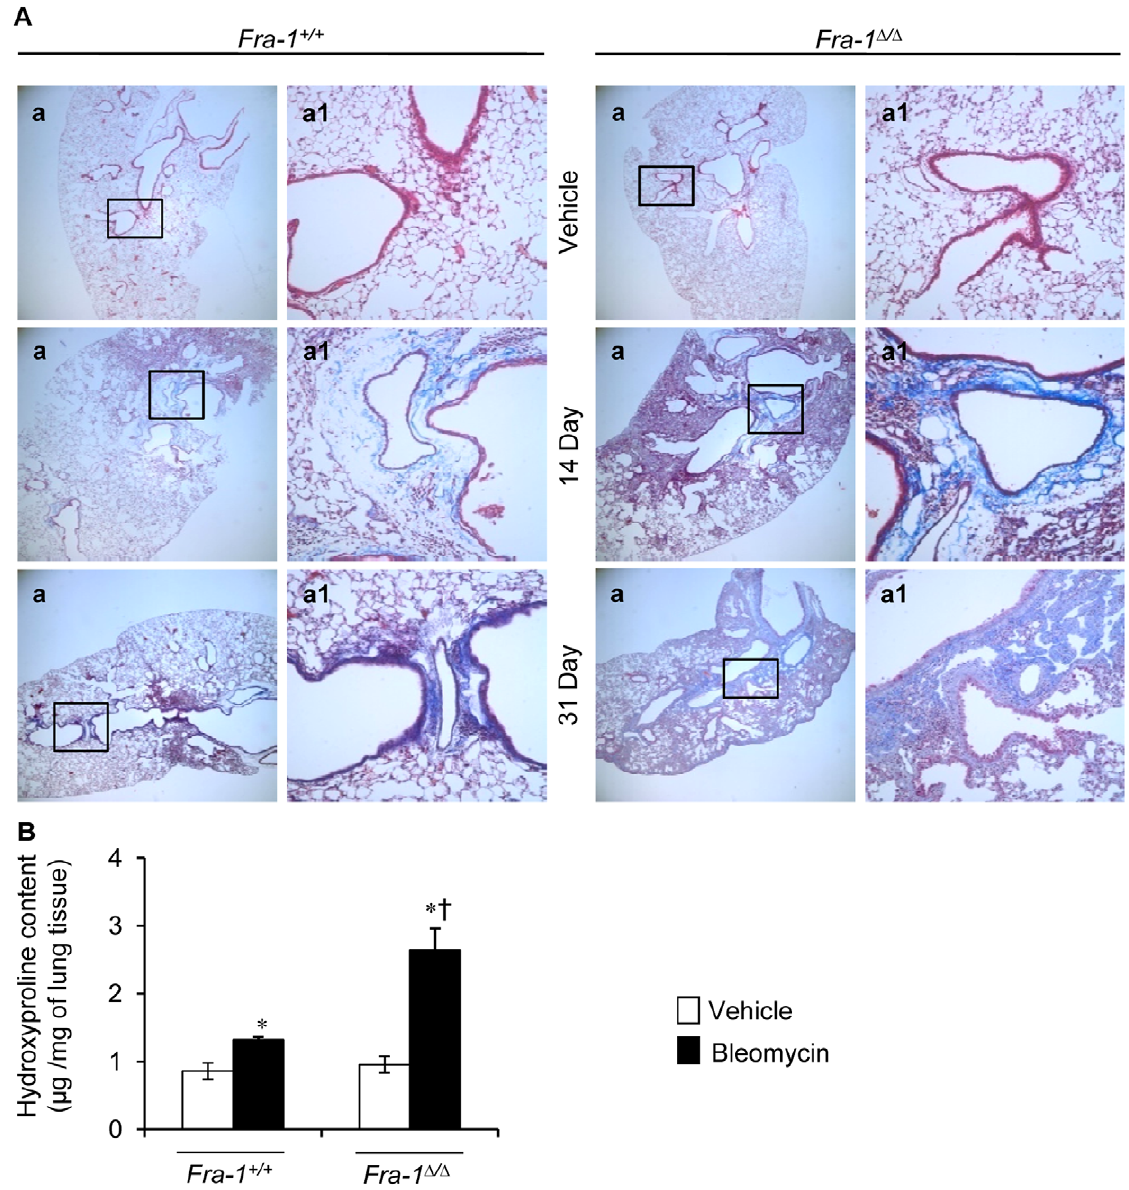
Figure 4. Fra-1 D / D mice develop exaggerated pulmonary fibrosis after injury. A: Representative results of Masson’s trichrome staining of the lung from the saline-treated mice (n=3) or bleomycin treated mice for 14 (n=3) and 31 (n=4) days. B: Right lung was collected for biochemical analysis of bleomycin-induced pulmonary fibrosis as measured by hydroxyproline content at 31-day post-PBS and -bleomycin treatment (n=5). p , 0.05, PBS vs bleomycin; { p , 0,05, Fra-1 D / D vs Fra-1 + / + mice. Images in a are shown at x4, whereas a1 represent boxed areas of a , shown at x20.